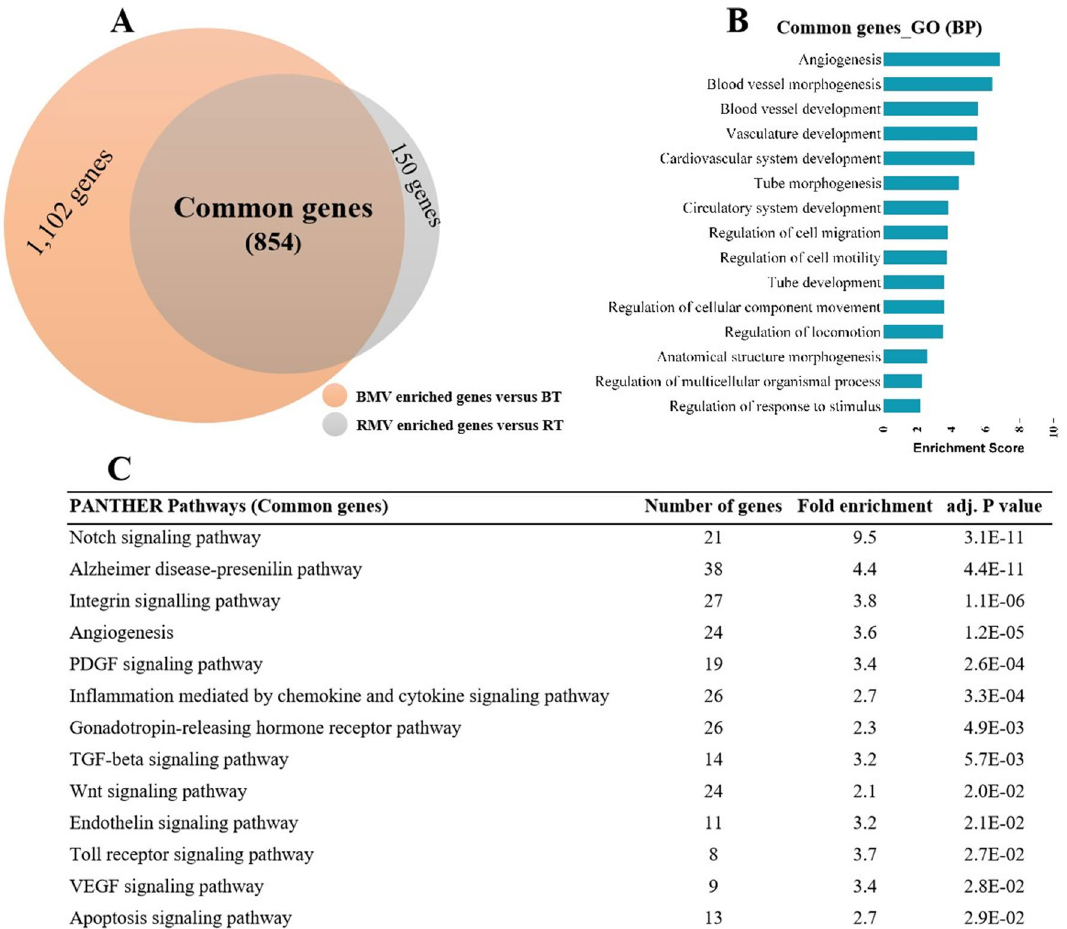
Figure 5. Gene expression comparison between RMVs and BMVs in rats (n = 6). (A) Venn diagram showing the numbers of genes that are significantly higher expressed in microvessels (MVs) obtained from the retina (RMVs, 1,004 genes) and from the brain (BMVs, 1956 genes). A total of 854 genes were commonly enriched in both, RMVs and BMVs. (B) Top 15 gene ontology (GO) biology processes (BP) identified from the 854 common genes. (C) Top 13 PANTHER pathways identified from the 854 common genes. All the biological processes shown are ranked by enrichment score with a Bonferroni adjusted p < 0.05 level of